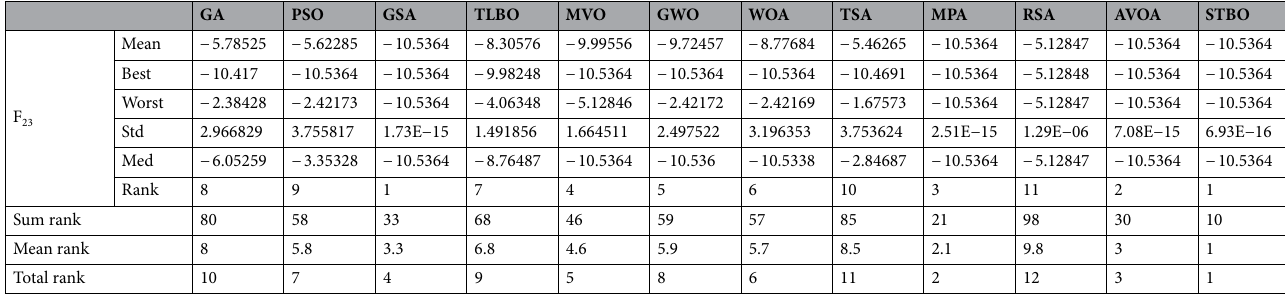
Table 5. Evaluation results on fixed-dimensional multimodal